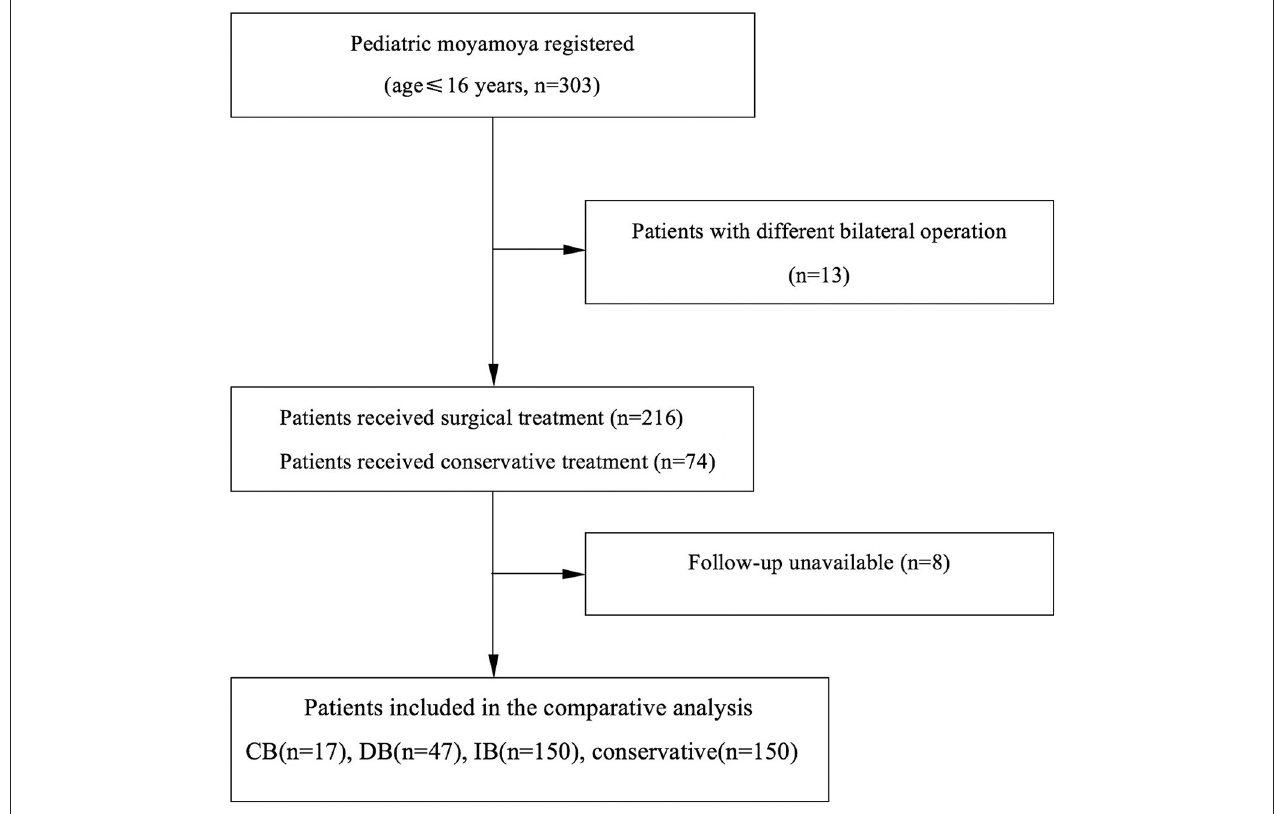
FIGURE 1 | Flow diagram of the study